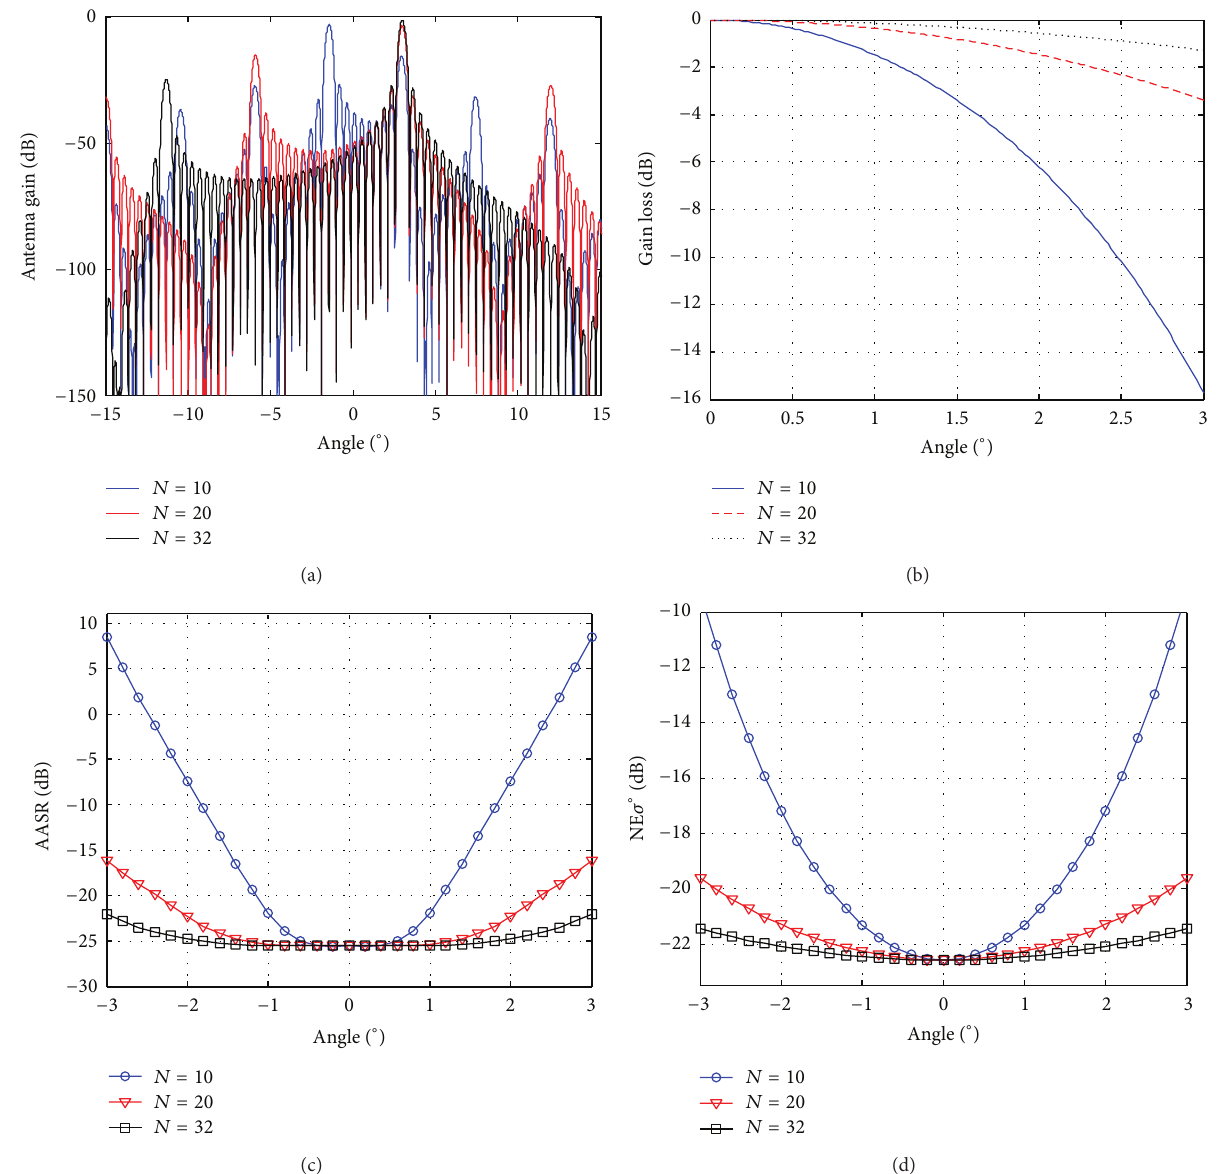
Figure 5: (a) AAP, assuming a steering to 3 ∘ , (b) Antenna gain loss, (c) AASR, and (d) NESZ for different number of antenna columns.